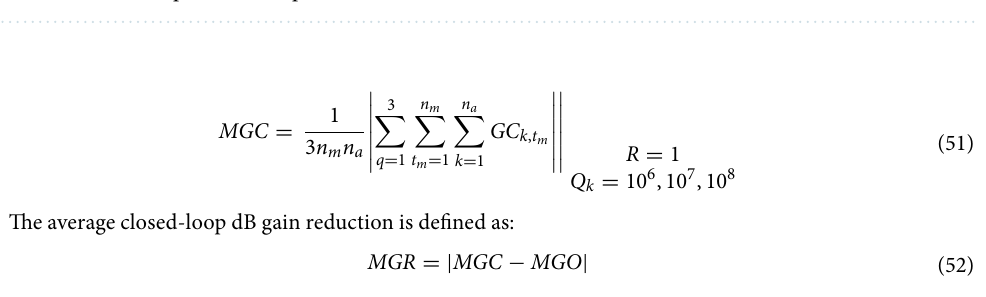
Table 3. Location of piezoelectric patches in different cases.